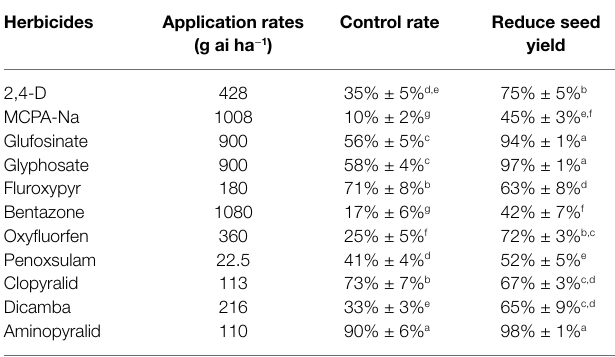
TABLE 2 | The 11 herbicides used in the experiment. Herbicides